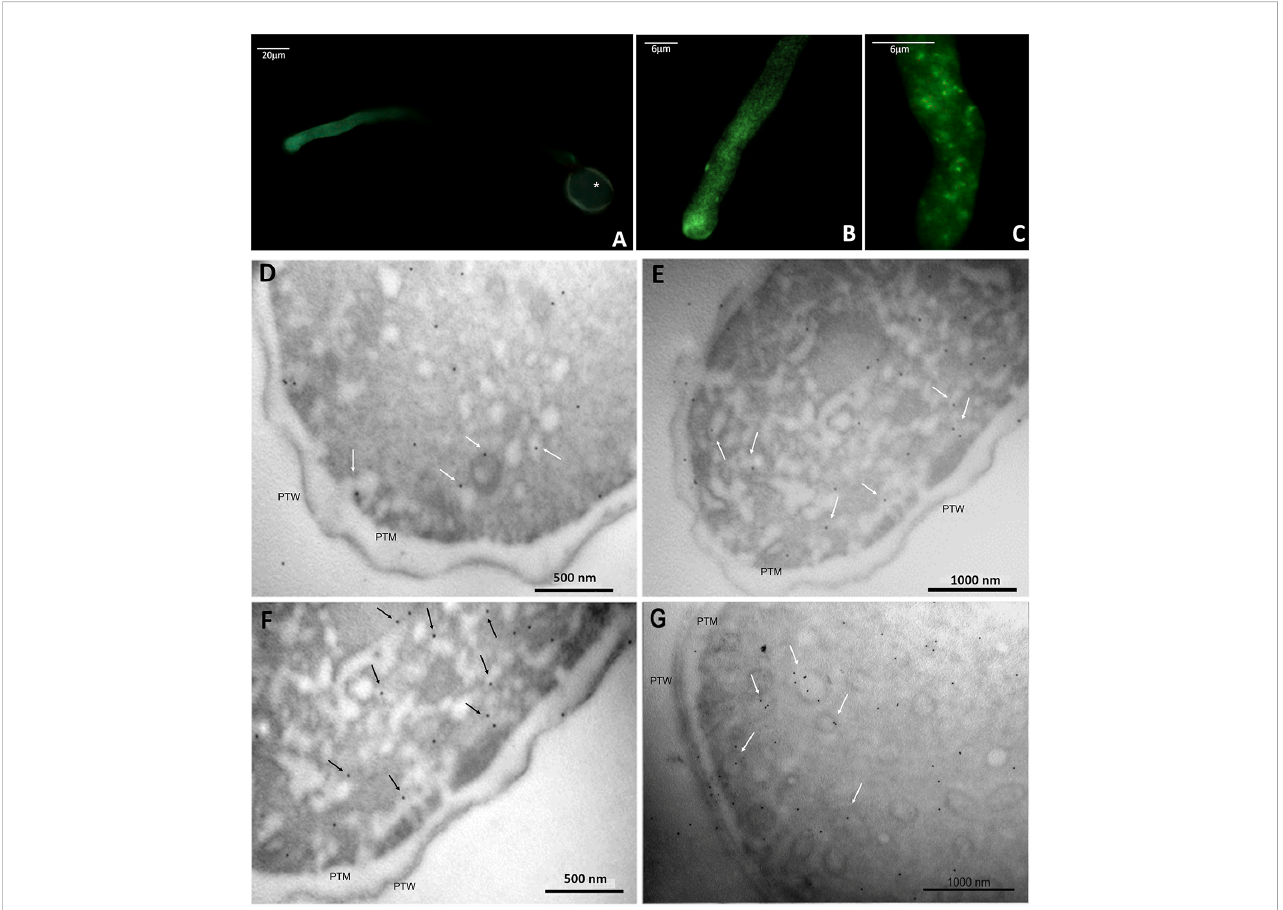
FIGURE 9 Immunolocalization of ALIX-homologs in kiwi pollen tube. (A – C) : indirect immuno fl uorescence labeling with FITC-conjugated secondary antibodies, probed for ALIX-homologs, at different magni fi cations.Tthe fl uorescent labeling of the target proteins is pictured in green. In A, the auto fl uorescence of the pollen wall is visible (*). (D – F) : immunogold labeling of ALIX-homologs in transverse sections of kiwi pollen tube. Images were taken at the level of apex and subapex. Some of the proteins appear associated with subcellular structures compatible with vesicles (arrows), near the plasma membrane. PTW, pollen tube wall; PTM, pollen tube plasma